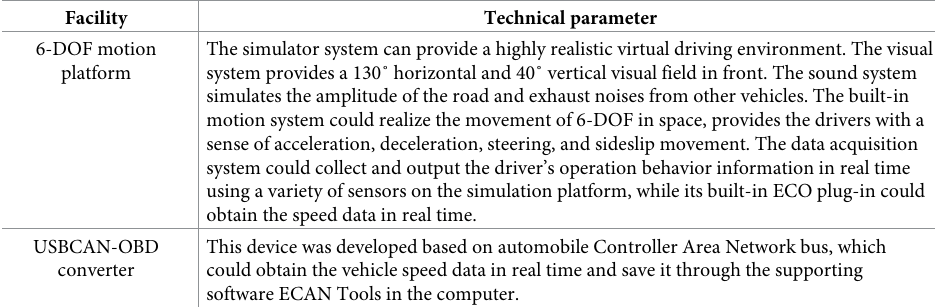
Table 1. Summary of test equipment.